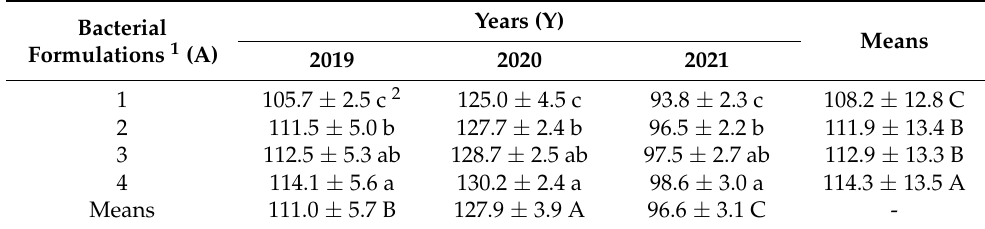
Table 1. Total protein content in spring barley grain according to test bacterial formulations in g · kg − 1